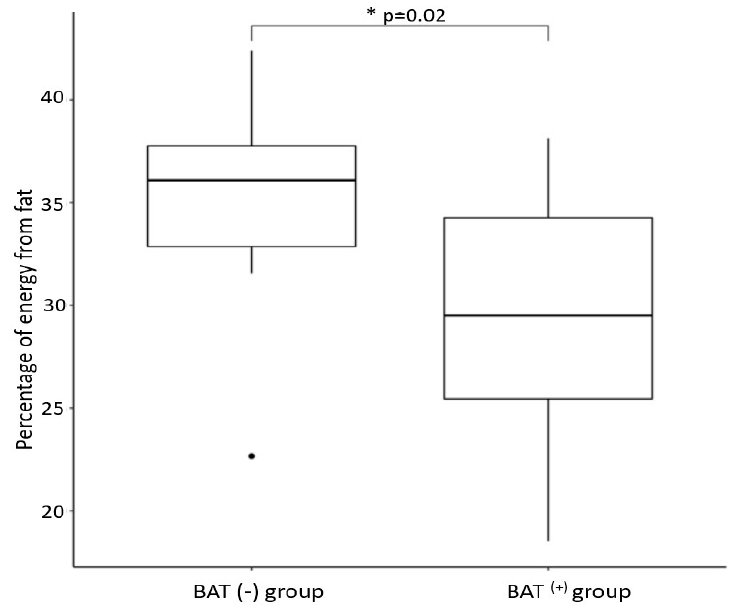
Figure 3. Percentage daily energy from fat in subjects depending on BAT status * p = 0.02.